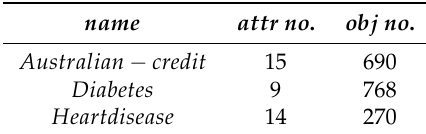
Table 4. Exemplary decision systems from UCI Machine Learning Repository [20]. We have chosen binary systems. name attr no . obj no